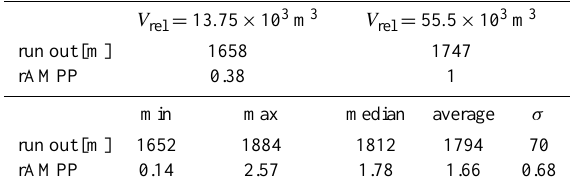
Table 1. Runout and rAMPP for reference V rel = 55 . 5 × 10 3 m 3 and V rel = 13 . 75 × 10 3 m 3 simulation runs. Additionally the minimum, maximum, median, average and standard variation of the result in- dicators are shown. V rel = 13 . 75 × 10 3 m 3